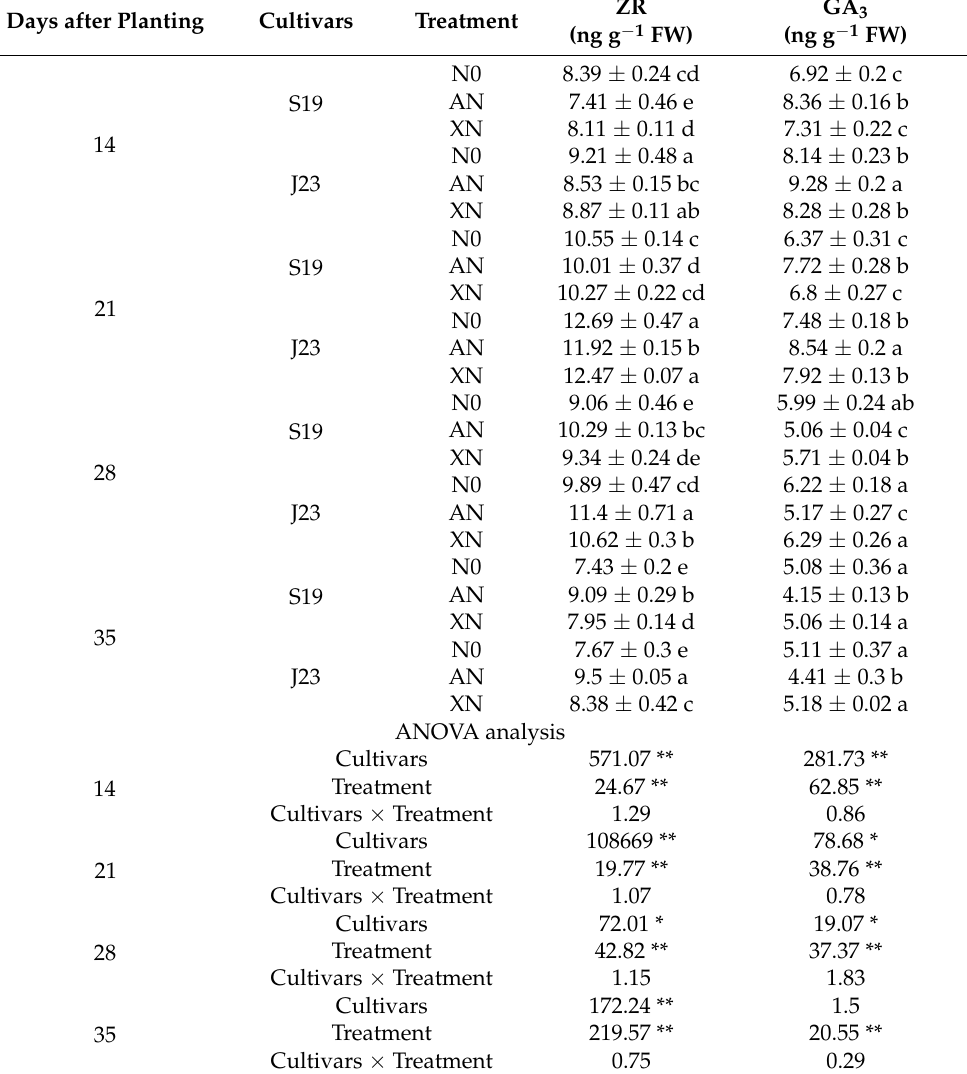
Table 4. ZR and GA 3 contents in potential storage roots of sweet potato during storage root formation. Days after Planting